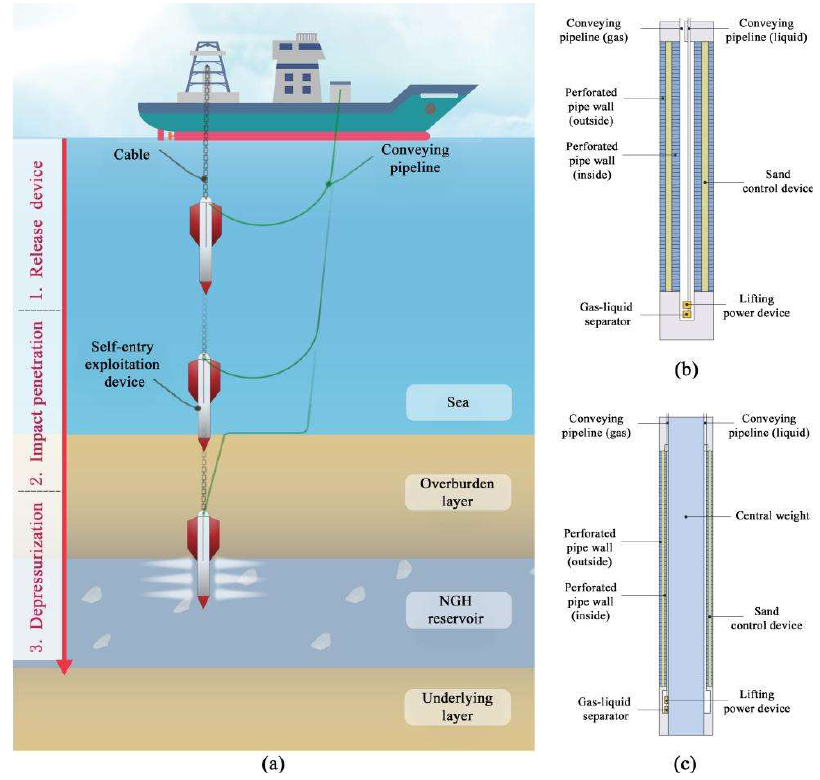
Figure 2. Main features of the self-entry exploitation device: ( a ) overall exploration schematic; ( b ) internal structure mode I; and ( c ) internal structure mode II. ( b ) internal structure mode I; and ( c ) internal structure mode